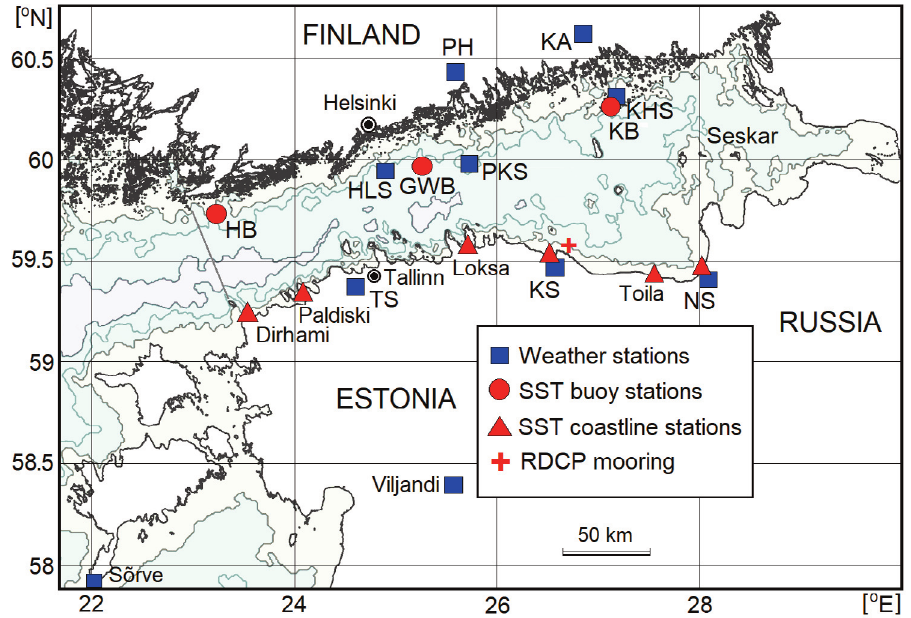
Fig. 1. Map of the study area with the locations of selected marine and weather stations. Water temperature: GWB (Gulf of Finland wave buoy), HB (Hanko Längden buoy), KB (Kotka Kuusenkari buoy), KS (Port of Kunda). Weather data: HLS (Helsinki Lighthouse), PKS (Porvoo Kalbådagrund), KHS (Kotka Haapasaari), PH (Porvoo Harabacka), KA (Kouvola Anjala), KS (Kunda), TS (Tallinn-Harku), NS (Narva, Narva-Jõesuu). Additional water temperature data from NS, KS, Toila, Loksa, Paldiski and Dirhami. + RDCP, Recording Doppler Current Profiler mooring (water temperature and salinity) off the Letipea Peninsula. The border of the Gulf of Finland is marked with a line in the gulf’s entrance